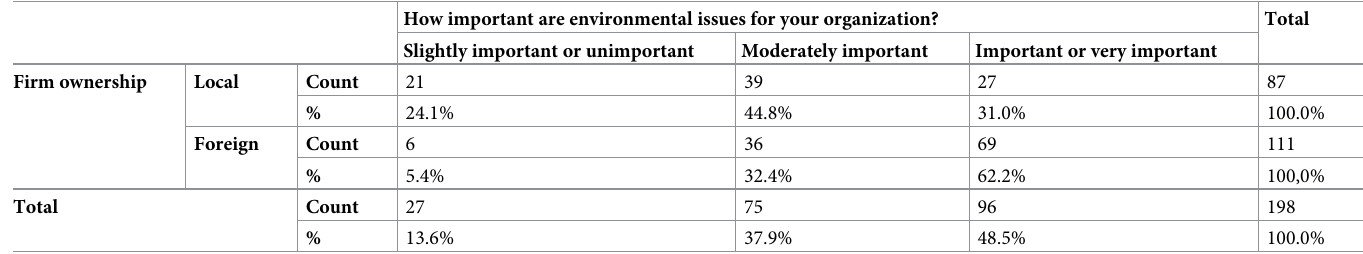
Table 3. The distribution of responses to the question about the importance of environmental issues for the organization. How important are environmental issues for your